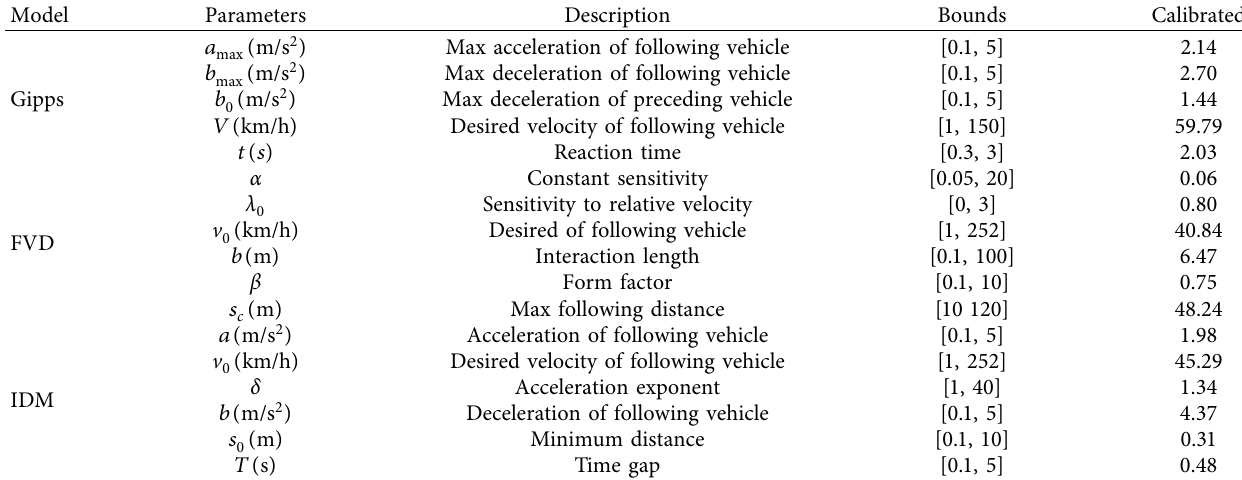
Table 3: Model parameters calibration results.